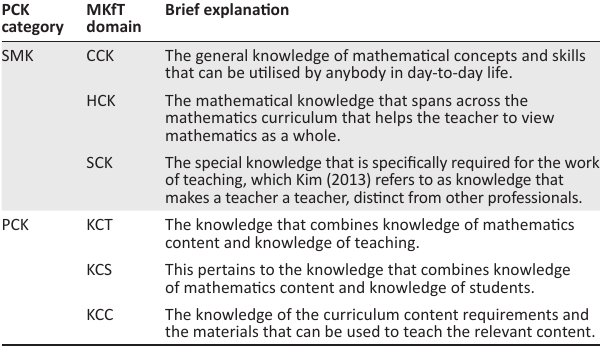
TABLE 1: An explanation of the mathematics knowledge for teaching